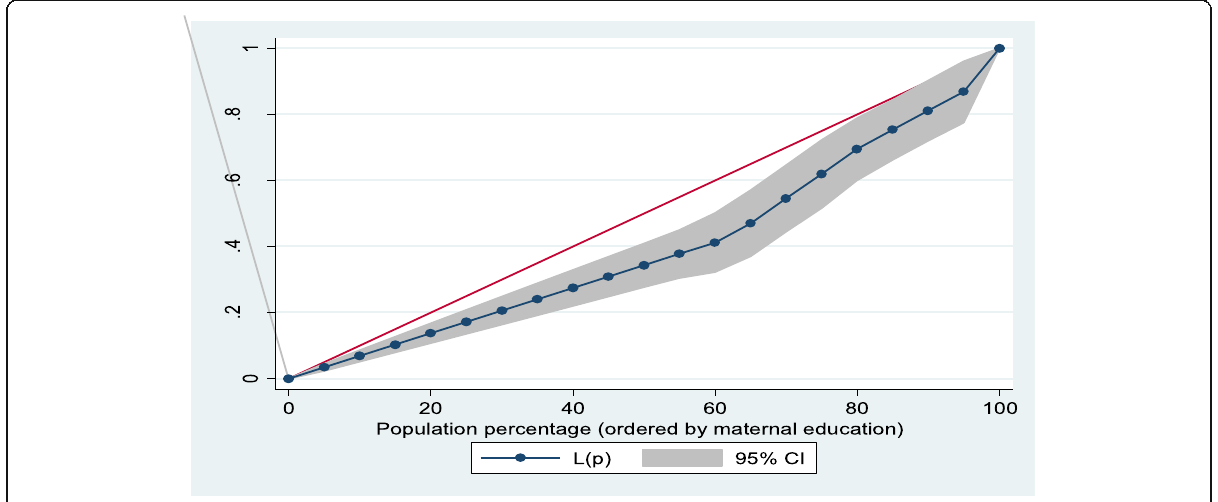
Fig. 4 Overall maternal education inequalities of ≥ 8 ANC